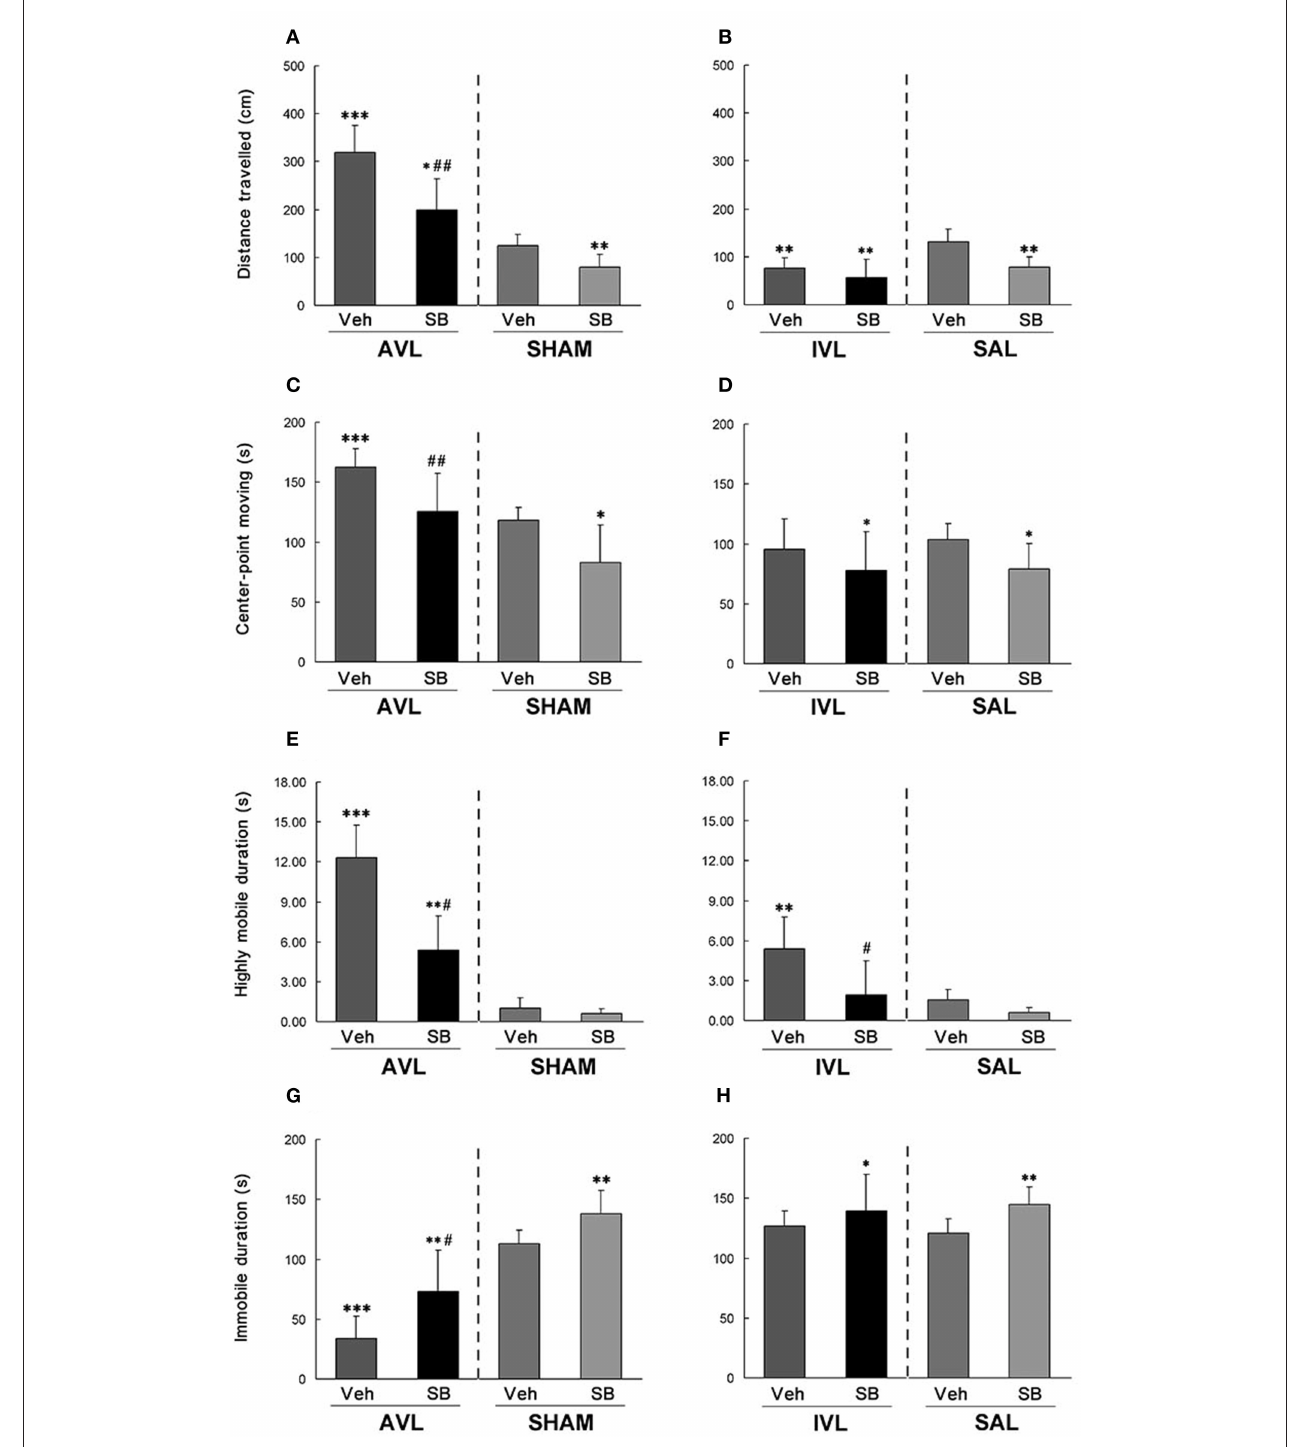
FIGURE 4 | Effects of the orexin receptor type 1 (OX 1 R) antagonist SB334867 on exploratory behavior in the open field after vestibular lesions induced by arsanilate and IDPN in rats. Total distance traveled (A,B) , body center-point moving duration (C,D) , highly mobile duration (E,F) and immobile duration (G,H) were analyzed; AVL, arsanilate - induced vestibular lesion; SHAM, sham control; IVL, IDPN - induced vestibular lesion; SAL, saline control; Veh, vehicle solution; SB, SB334867. Data are represented as mean ± SEM. * P < 0.05, ** P < 0.01, *** P < 0.001 compared with SHAM or SAL vehicle control group; # P < 0.05, ## P < 0.01 compared with AVL or IVL vehicle control